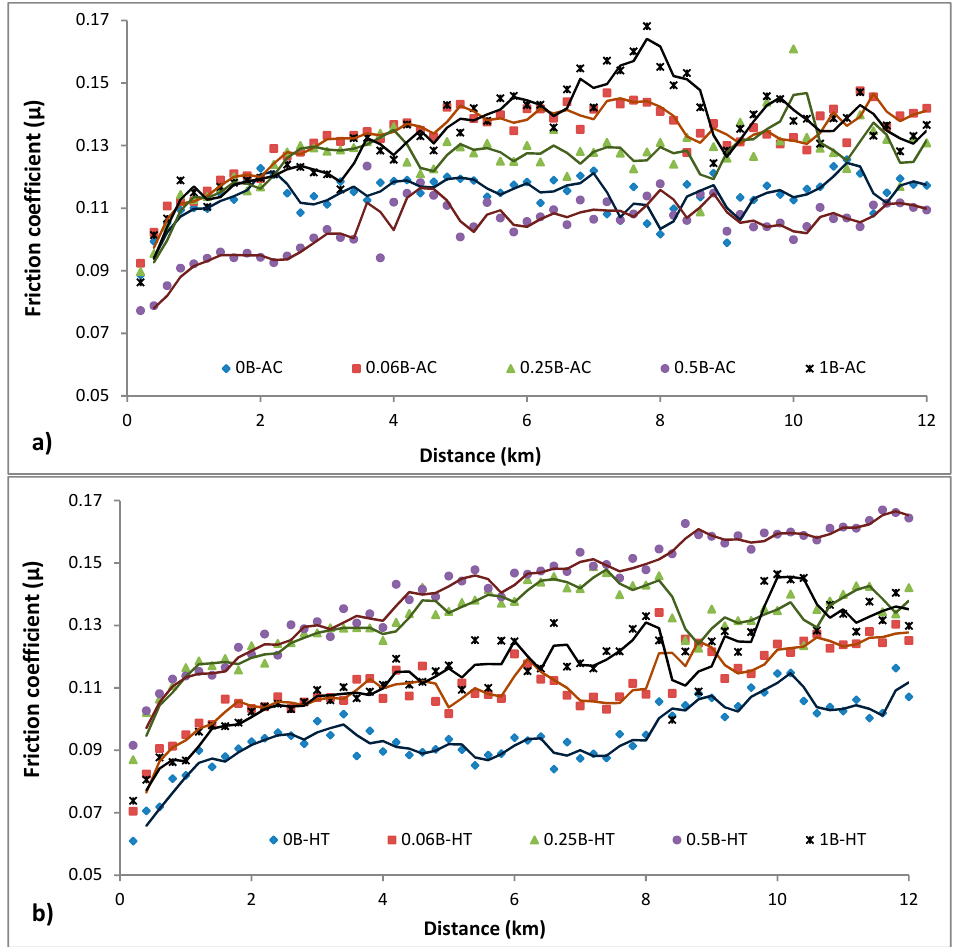
Figure 4. Friction coefficient during the ball-on-disc tests; ( a ) as-cast alloys and, ( b ) heat-treated alloys. Metals 2021 , 11 , x FOR PEER REVIEW